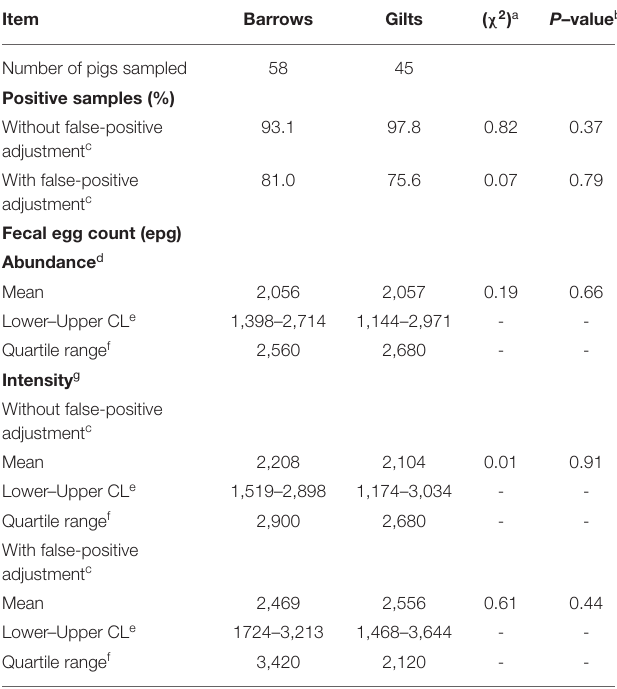
TABLE 2 | Positive samples and fecal egg counts, measured in eggs per gram (epg), of Ascaris suum in barrows vs gilts at 23 weeks of age.